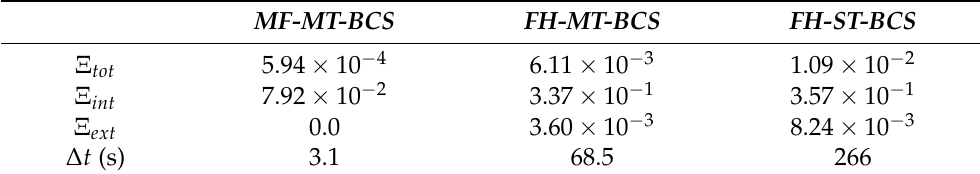
Table 1. Numerical assessment (“ Diagonal ” Scatterer , τ = 1.0 − j 0.4, N = 400, SNR = 35 dB)—Total, internal, and external reconstruction errors [9] and inversion time for the MF-MT-BCS , the FH-MT- BCS , and the FH-ST-BCS methods.